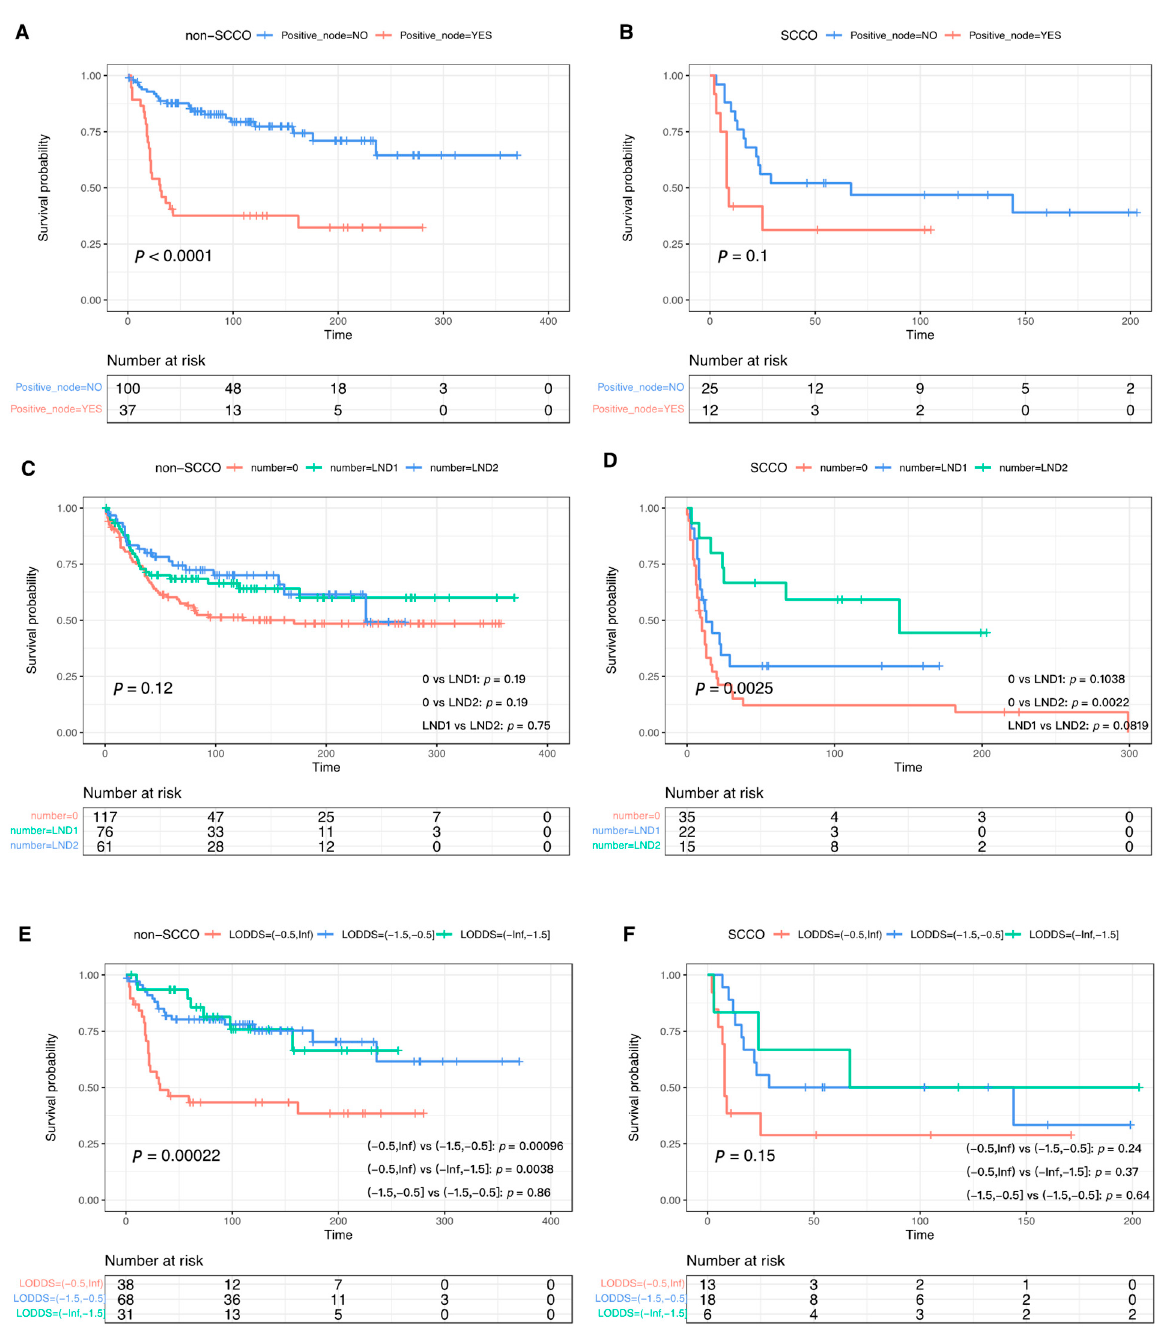
Figure 3. Survival curves of overall survival among patients with all stage ( A , B ), early stage ( C , D ), and advanced stage ( E , F ) in non-SCCO and SCCO in matched cohort divided by lymphadenec- tomy.